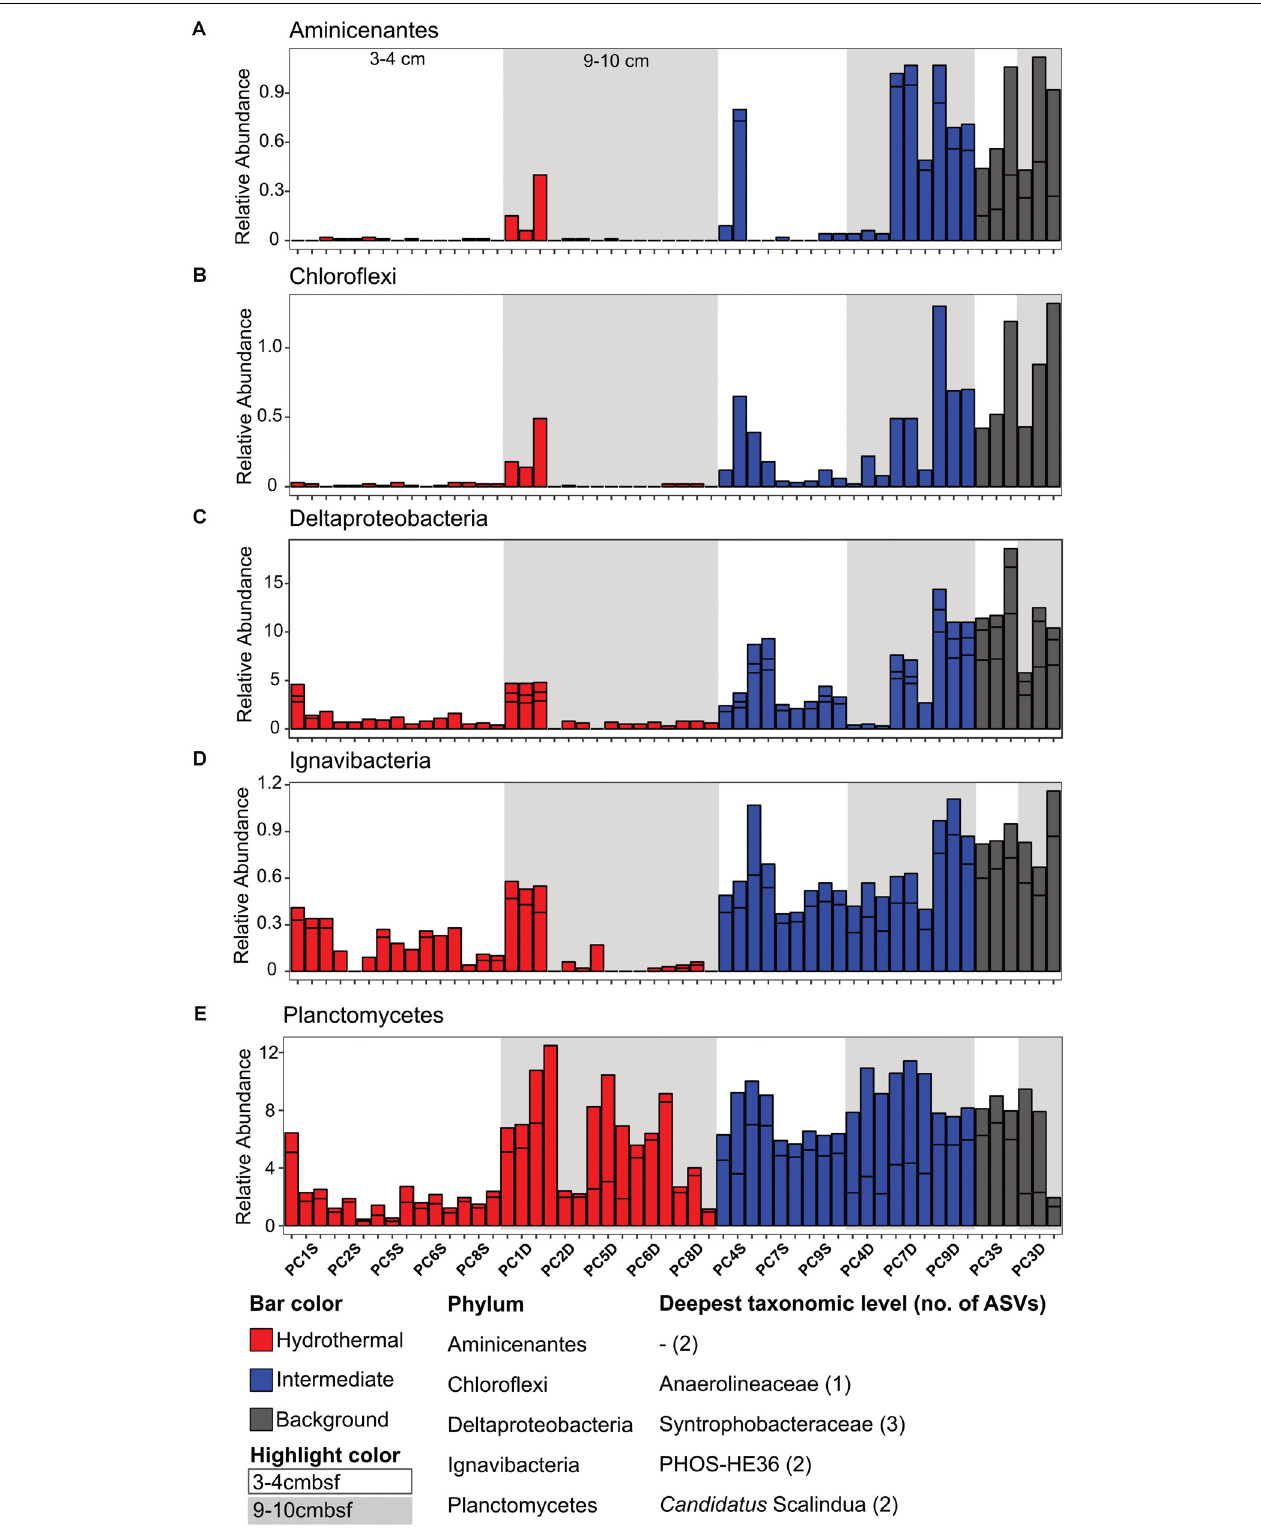
FIGURE 5 | Select ASVs associated with (A) Aminicenantes, (B) Chloroflexi, (C) Deltaproteobacteria, (D) Ignavibacteria, and (E) Planctomycetes which were more abundant in the background and/or the background plus intermediate samples. Bars are colored by sample, and divided by ASV abundance. Relative abundance is in percent of total sequences per sample. The deepest taxonomic level assigned are listed next to the phylum followed by the number of ASVs graphed.